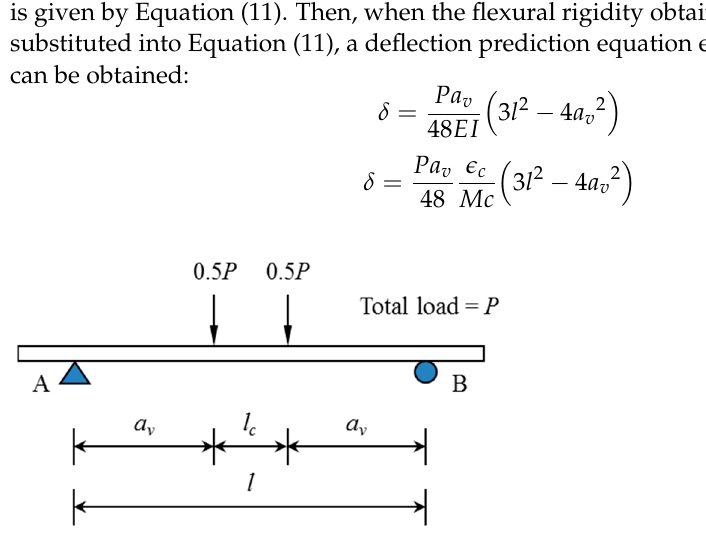
Figure 10. Imposed point loading condition in the